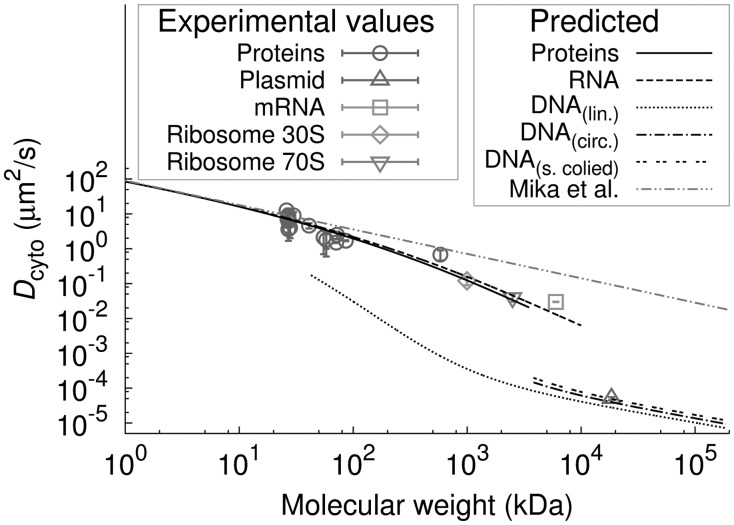
Comparison of measured and predicted  as a function of molecular weight of the investigated probes. Predicted dependencies shown in the graph are expressed by Equation (7). The hydrodynamic radius  of each type of macromolecules is given by the relationship:  nm, where  is the molecular weight of the macromolecule. For proteins C = 0.0514 and α = 0.392—Equation (1); RNA C = 0.0566 and α = 0.38—Equation (2), linear DNA C = 0.024 and α = 0.57—Equation (3); circular DNA C = 0.0125 and α = 0.59—Equation (4); super coiled C = 0.0145 and α = 0.57—Equation (5). For comparison, we present experimental data on DCs of proteins (Cluzel et al., 2000; Elowitz et al., 1999; English et al., 2011; Konopka et al., 2006; Kumar et al., 2010; Mika et al., 2010; Mullineaux et al., 2006; Nenninger et al., 2010; Slade et al., 2009), RNA (Golding and Cox, 2004), plasmid (Campbell and Mullins, 2007) and ribosomes 30S and 70S (Bakshi et al., 2012). The dashed–dotted straight line indicates the relationship  proposed by Mika and Poolman (2011). The dependence of  on  proposed by Mika and Poolman (2011), when applied to large plasmids ( kDa), yields several orders of magnitude overestimation of DC